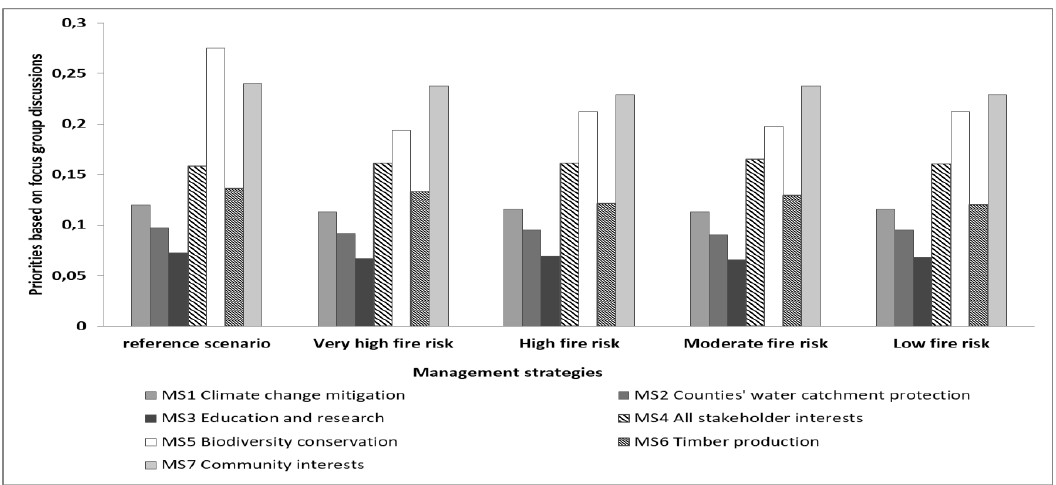
Figure 5. Priorities of the seven management strategies for the reference scenario and the four fire danger categories.